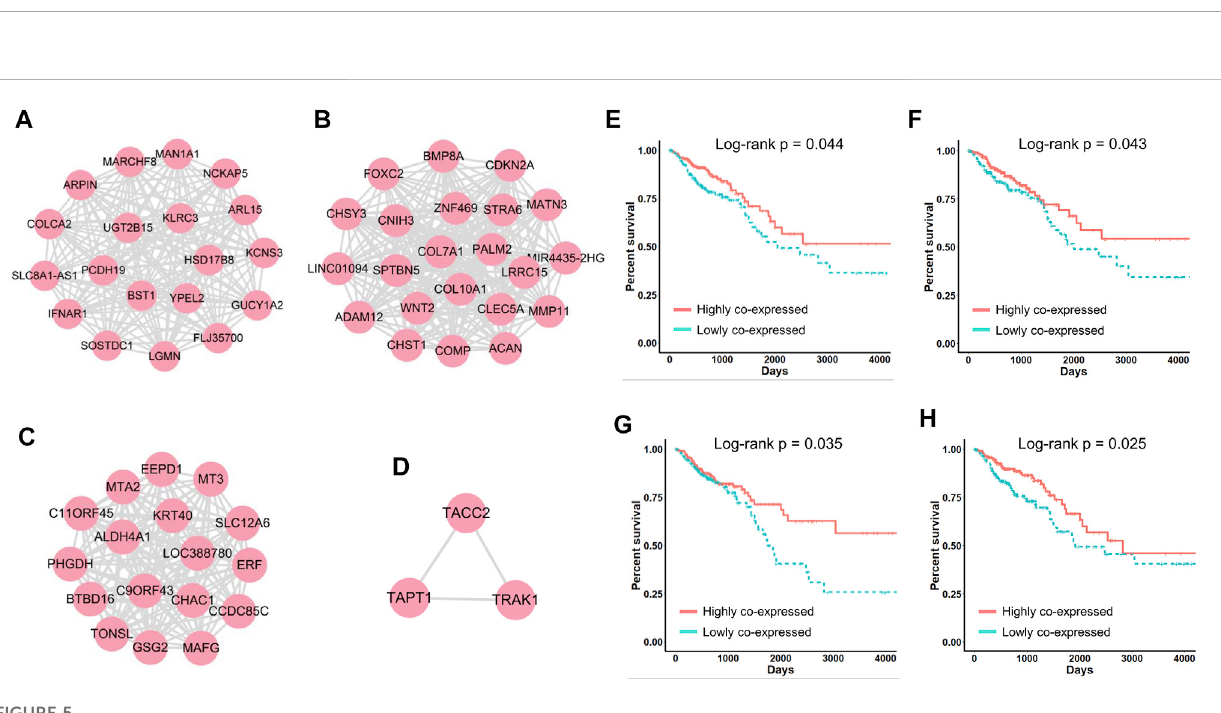
FIGURE 4 (A – C) Examples of classifying patients based on (A) the expression of single genes, (B) the average expression of genes in each module, and (C) the standard deviation of genes in each module, respectively. (D) The negative log10 of the log-rank test p -values generated by using single gene expression, average expression and standard deviation to classify patients.